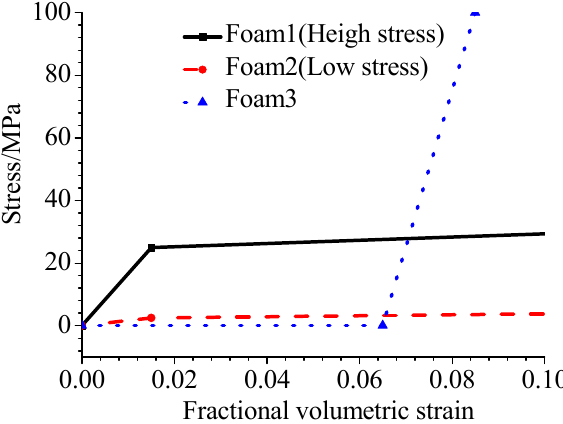
Figure 26. Stress versus volumetric strain curves for crushable foam materials.